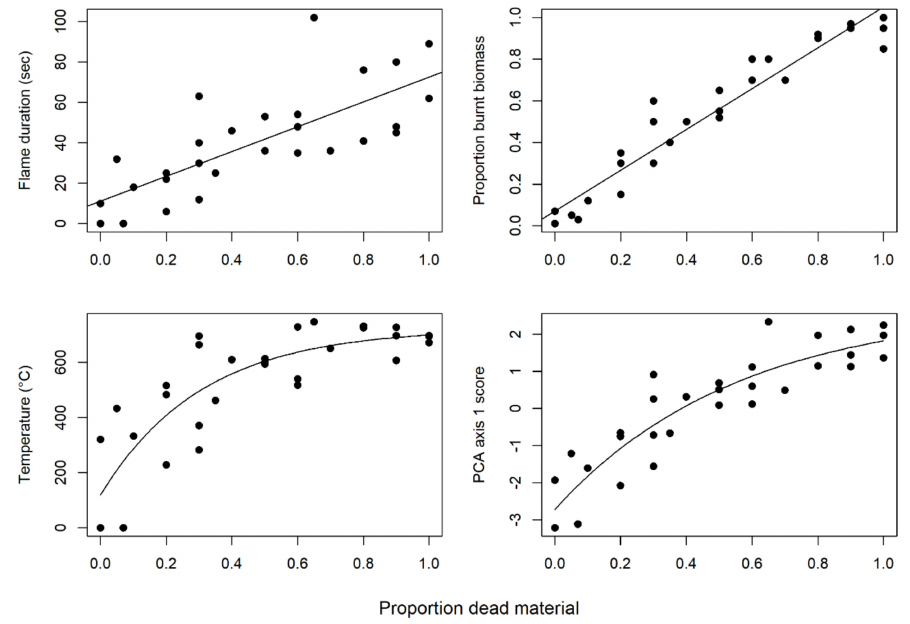
Figure 3. The relationship between the proportion of dead material in the burnt sample and the sustainability (flame duration (seconds)), consumability (burnt biomass), combustibility (temperature ( ◦ C) and overall flammability (PCA axis 1 scores) of the sample.